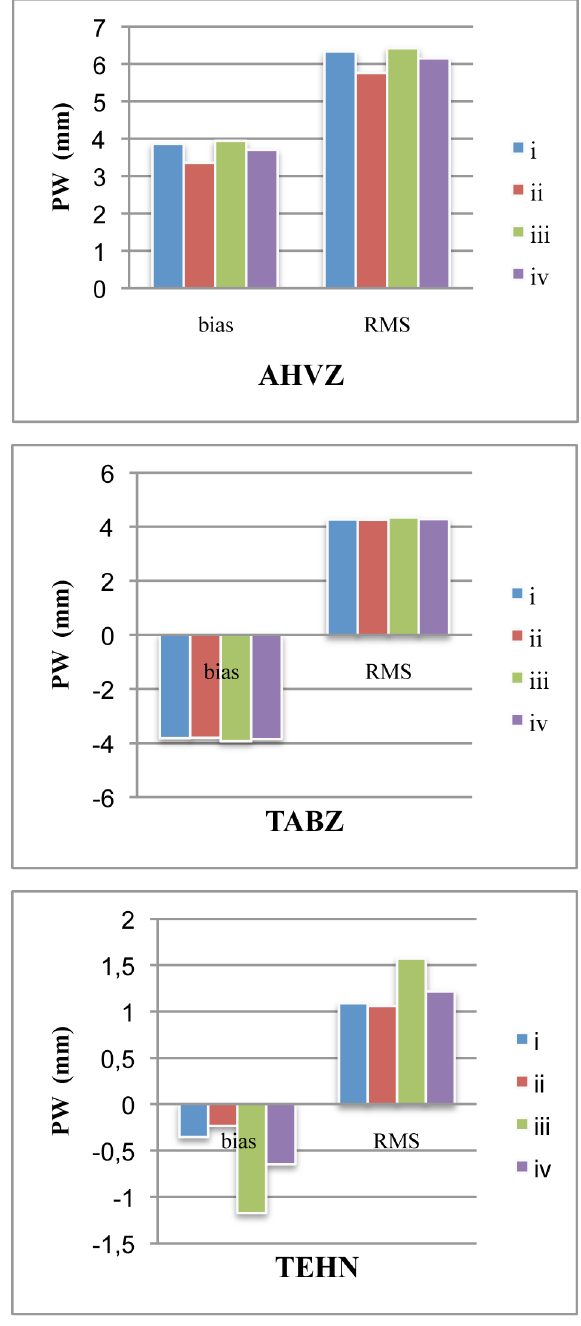
Figure 3 (top to bottom).The RMS and bias of the proposed as well as the existing models in the dry months: i) linear model proposed in Bevis et al. [1992], ii) linear model proposed in this research, iii) quadratic model proposed in Emardson and Derks [2000] and iv) quadratic model proposed in this